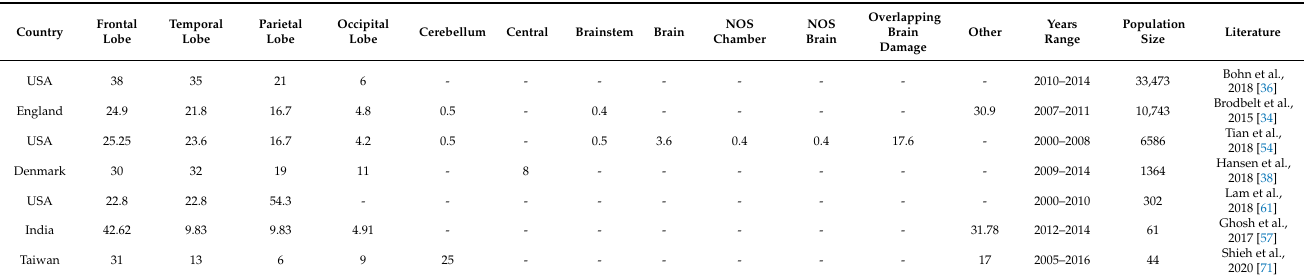
Table 2. Summary of percentage distributions of GBM locations in the central